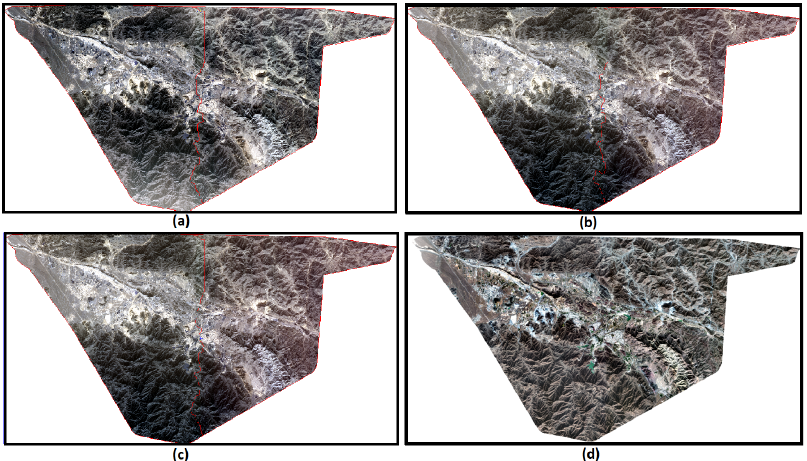
Figure 11. The color balancing outputs obtained in the South-Eastern part of WorldView-2 tiles provided in Figure 2 using different overlapping based approaches: ( a ) minimum squared difference with hot spot, ( b ) minimum difference with hot spot, ( c ) minimum difference with adaptive filter. ( d ) Proposed